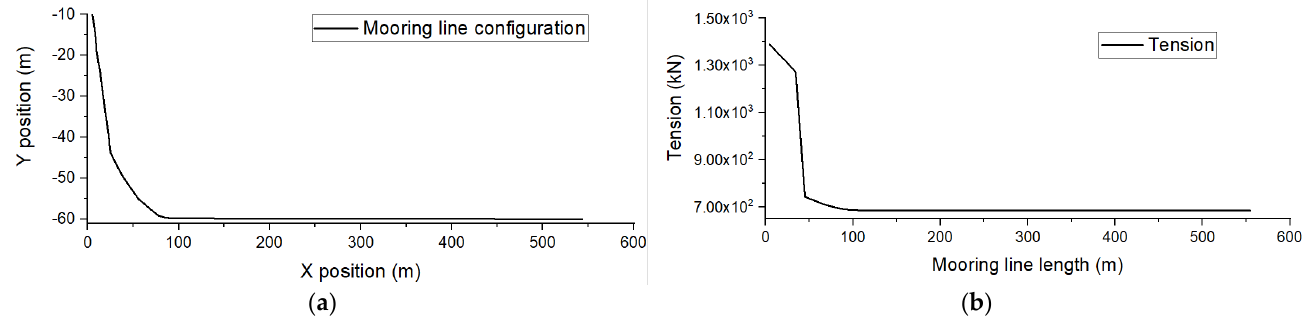
Figure 8. Mooring line configuration and axial tension of ML 1: ( a ) Static equilibrium configuration; ( b ) Axial effective tension.